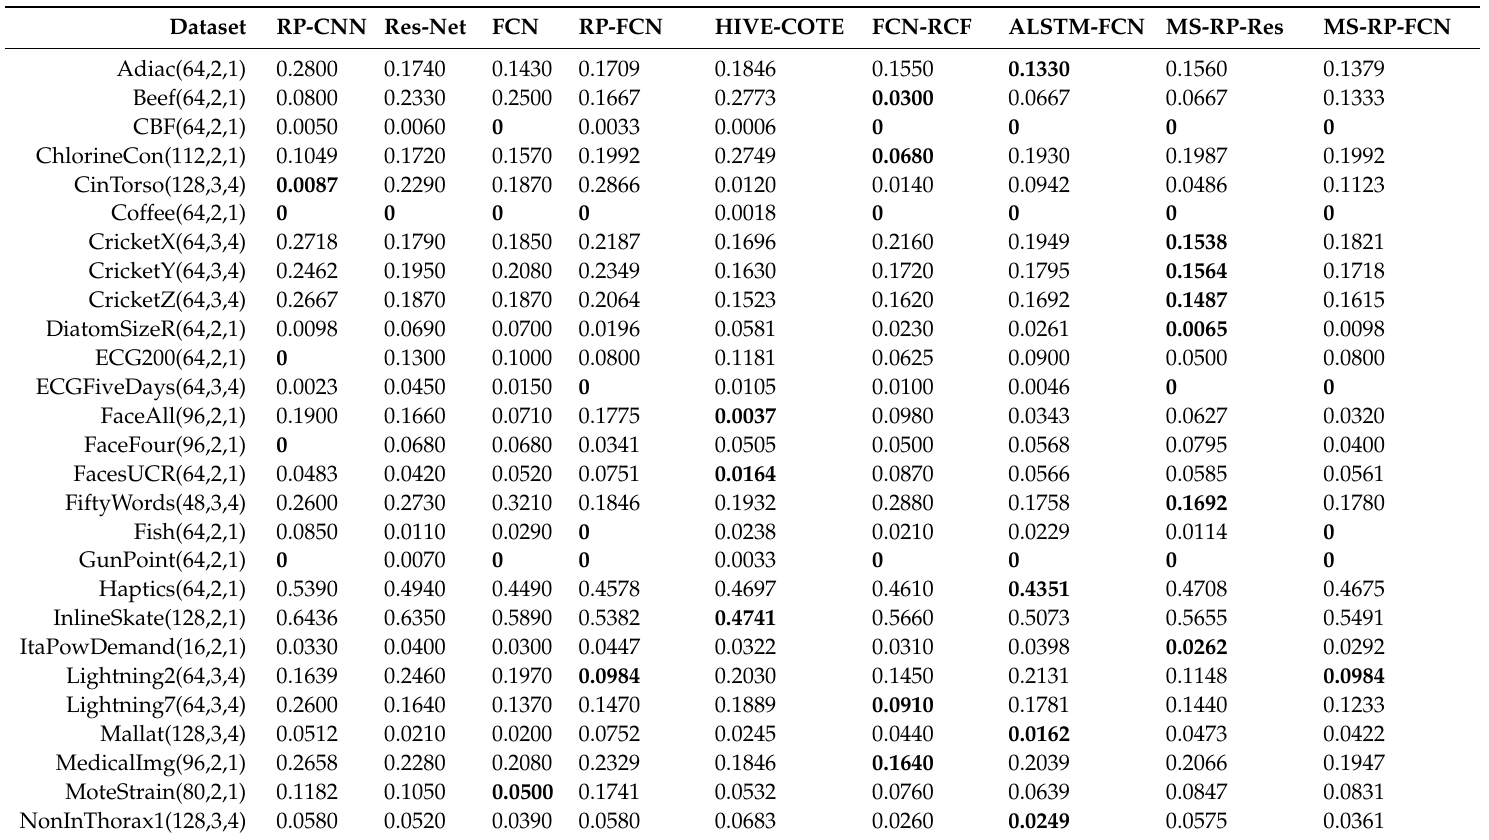
Table 2. Comparison in terms of classification error rates on 45 UCR